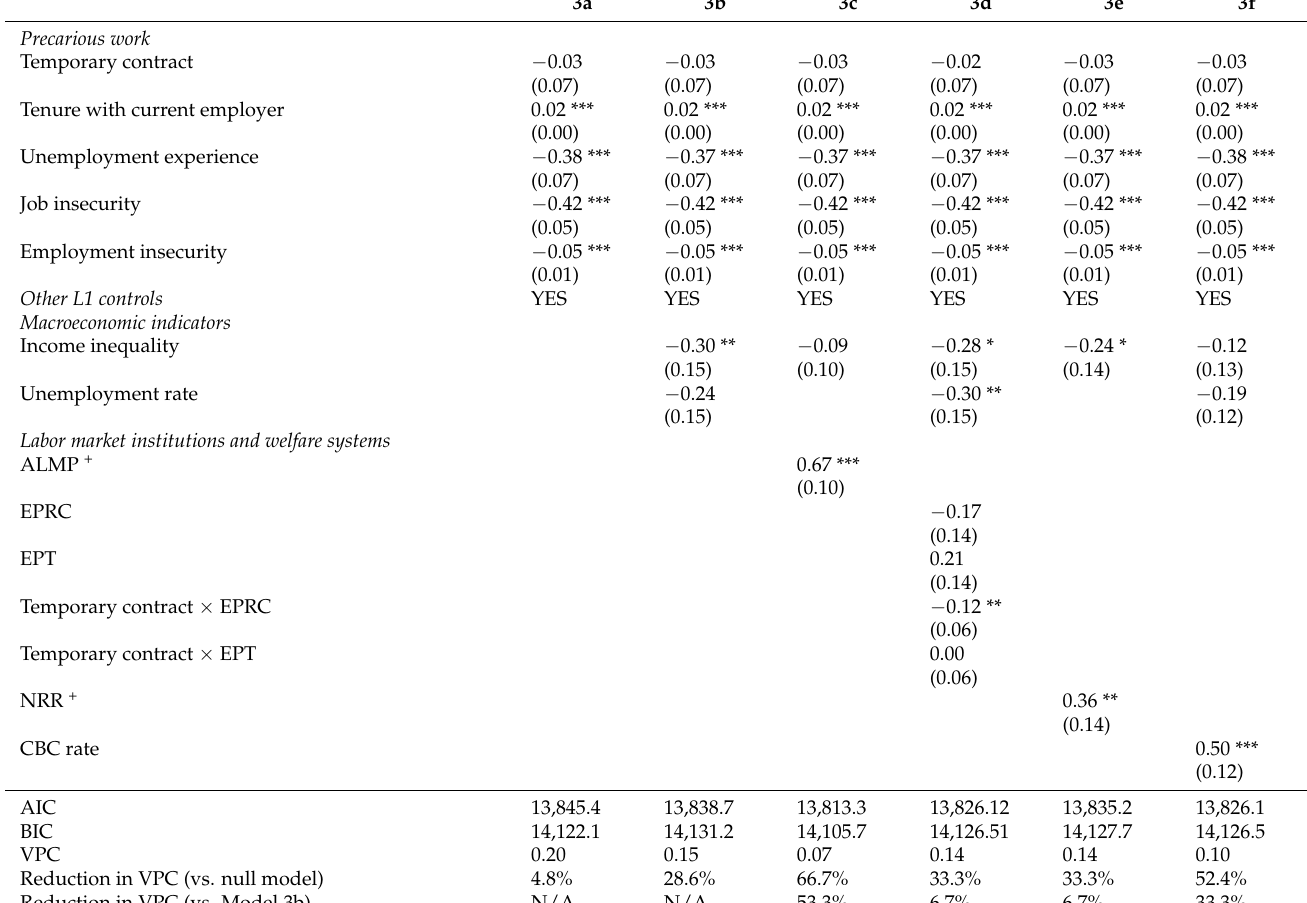
Table 3. Impact of labor market policies and welfare systems on economic